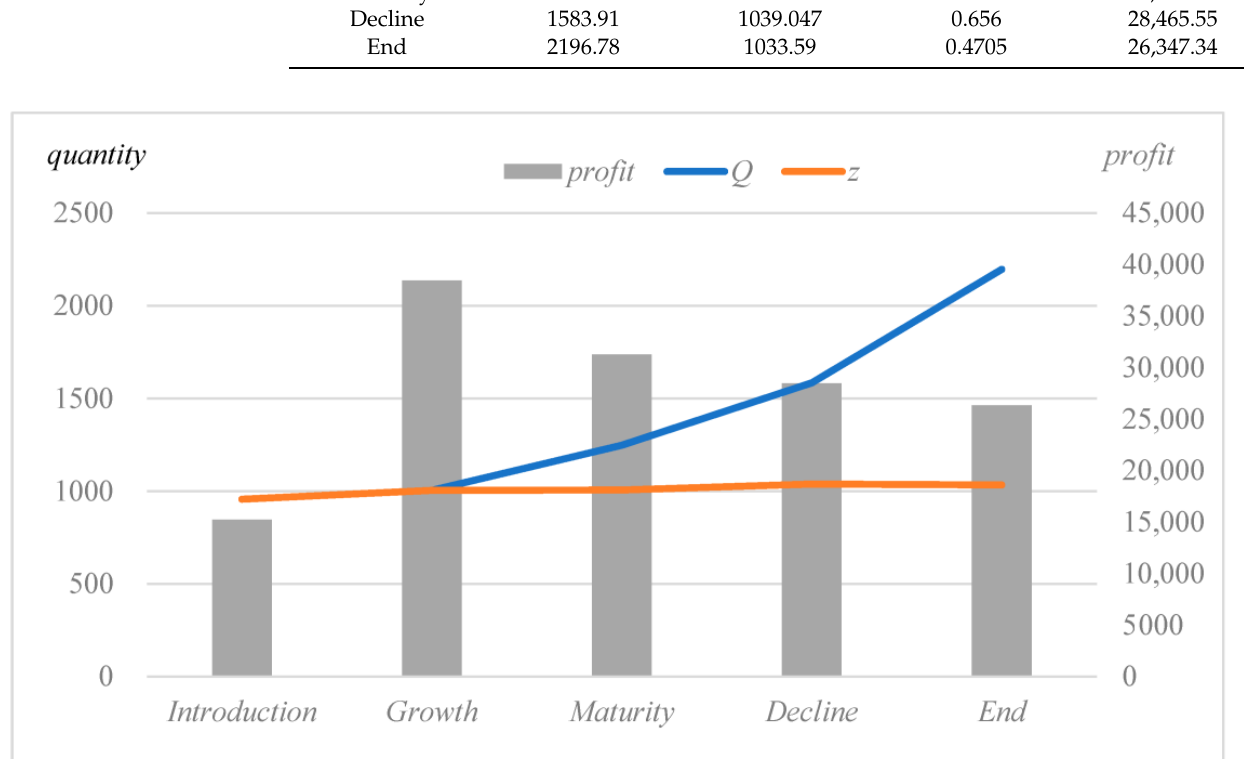
Figure 6. The results along the lifecycle.